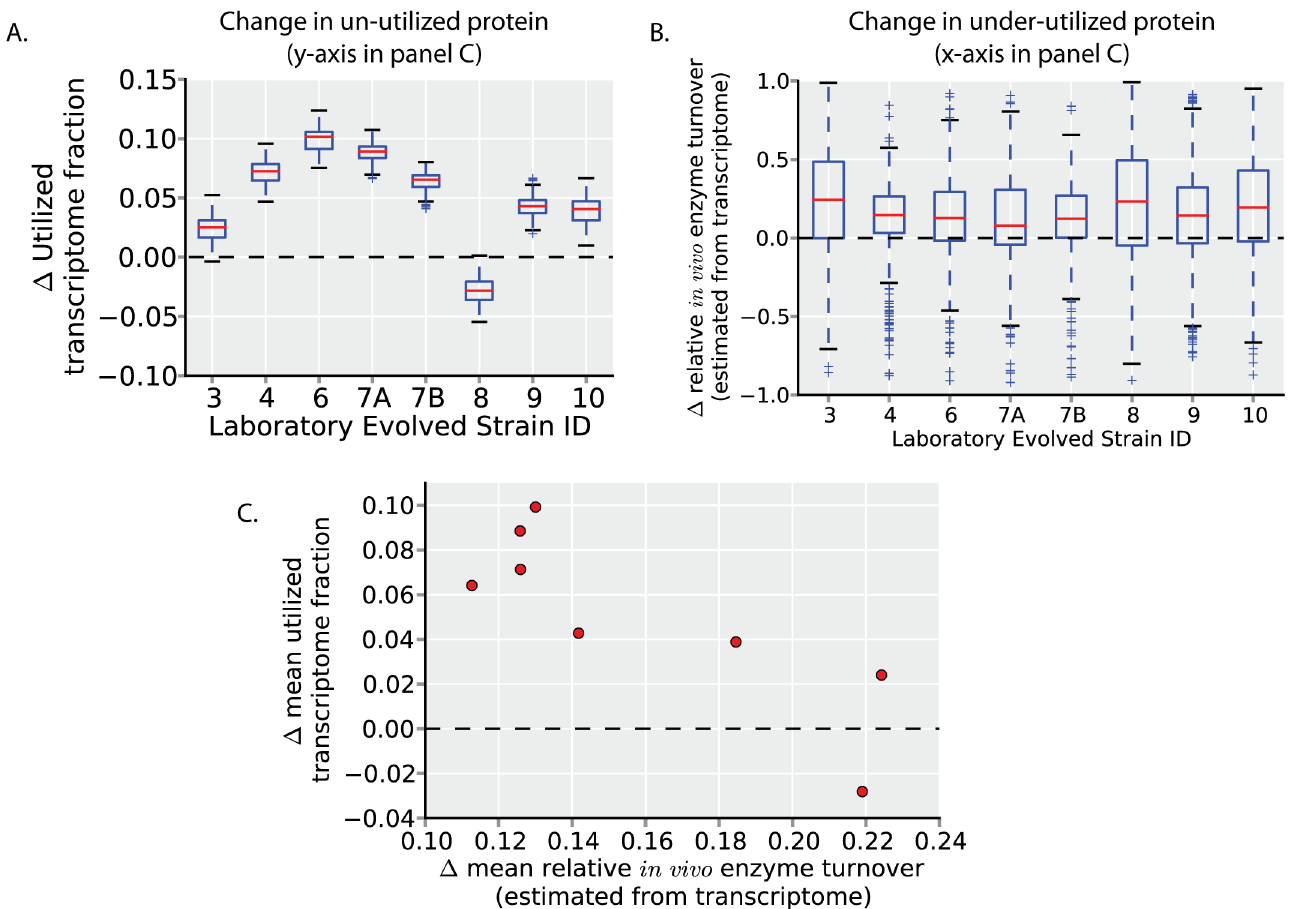
Fig 3. Growth rate increases through changes in unused protein allocation in adaptive evolution experiments. ( A ) The change in utilized transcriptome fraction of strains independently evolved in glucose minimal media [15] (which reached growth rates of ~1.0 h -1 , compared to the wild- type growth rate of 0.7 h -1 ) is calculated (see Methods). All strains except one (strain 8) show an increase in the utilized transcriptome fraction (i.e., a decrease in un-utilized transcriptome). ( B ) The estimated changes in relative enzyme turnover rates compared to the wild-type (unevolved) strain are calculated (as in Fig 1D and S1 Fig; see Methods). The distributions of all strains have a median value greater than zero, indicating a decrease in under-utilized protein in evolved strains. ( C ) The mean value of the estimated change in utilized protein (y-axis, from A) is plotted versus the mean value of the estimated change in under-utilized protein (quantified by change in relative in vivo enzyme turnover rates; y-axis, from B). The change in utilized transcriptome is anti-correlated with the change in in vivo enzyme turnover, indicating that the independently evolved strains use different strategies (i.e., a decrease in un-utilized versus a decrease in under-utilized protein) to increase growth